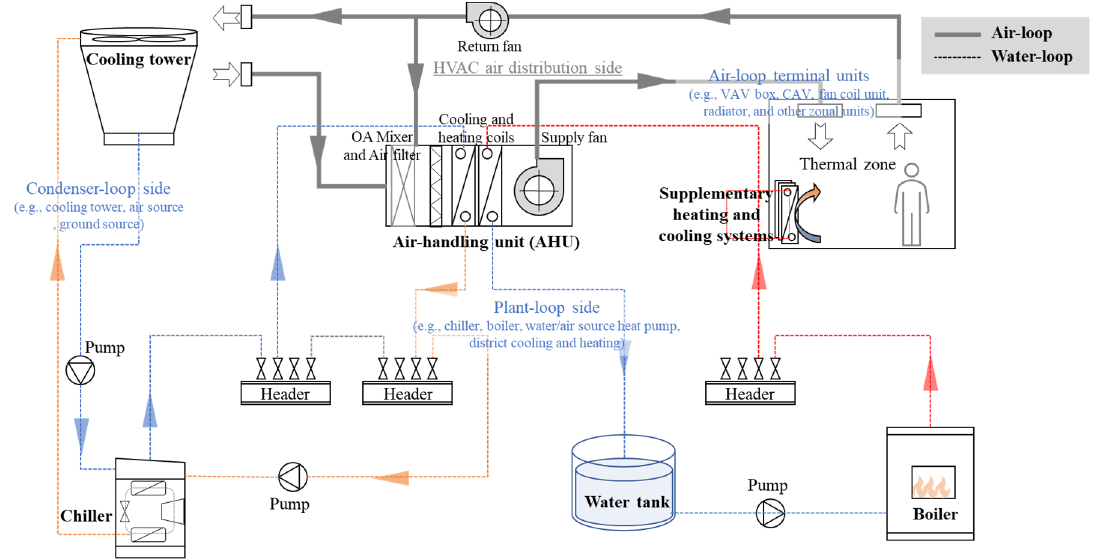
Figure 7. Schematic of typical HVAC air-loop and water-loop configuration.